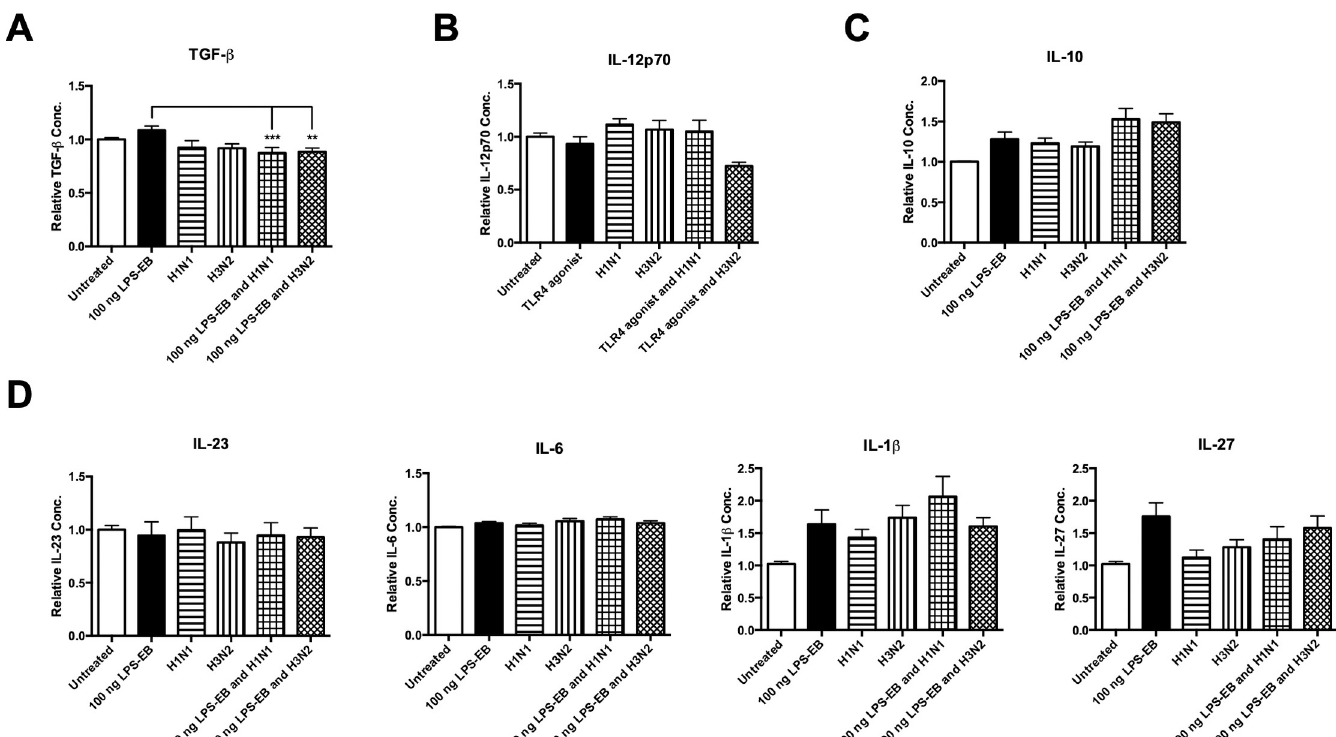
Fig 3. Live IAV targets TLR4-induced TGF- β in human monocytes. Levels of (A) TGF- β , (B) IL-12p70, (C) IL-10, (D) IL-23, IL-6, IL-1 β , and IL-27 secreted by CD14 + cells following 24 h treatment with a TLR4 mono-agonist (LPS-EB), live H1N1 or H3N2 alone or in combination with LPS-EB (or untreated as a control) were determined by ELISA. Each column represents normalised mean cytokine levels + SEM of 3 technical repeats of each treatment in every donor. Each ELISA represents normalised results from multiple donors (n): (A) TGF- β (n = 9), (B) IL-10 (n = 9), (C) IL-12p70 (n = 5), (D) IL-23 (n = 9), IL-6 (n = 9), IL-1 β (n = 9), and IL-27 (n = 9). Statistical analyses were performed to compare cytokine levels in cells treated with LPS-EB versus cells exposed to live H1N1 or H3N2 in combination with LPS-EB by fitting a One-Way ANOVA to the data and using a Sidak test to adjust for multiple testing ( �� p < 0.01, ��� p < 0.001).